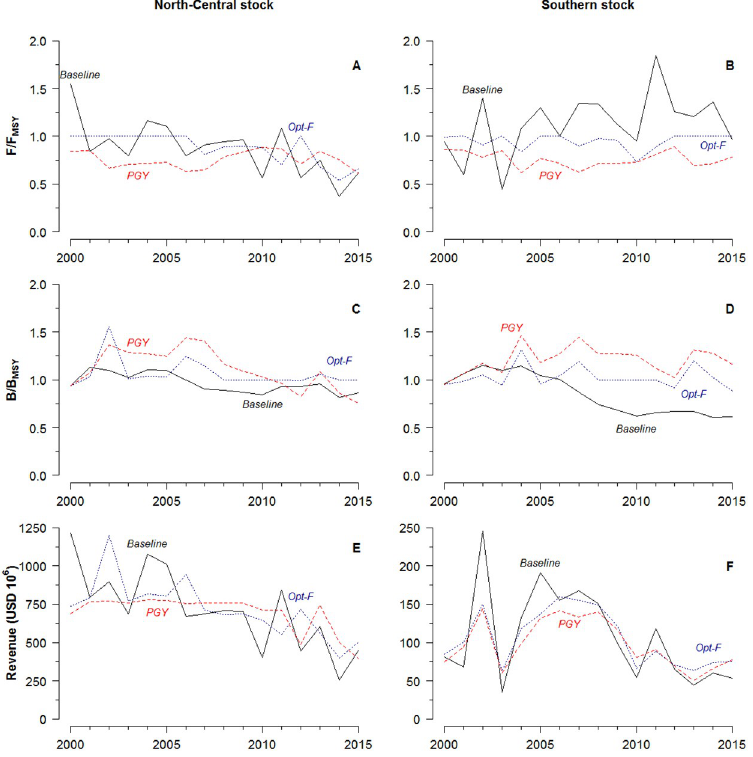
Fig 2. Fishing mortality (F/F MSY ), biomass (B/B MSY ), and fisheries revenues for the North-Central and Southern Peruvian anchoveta stocks under baseline, Optimized F (Opt-F) and pretty good yield (PGY)